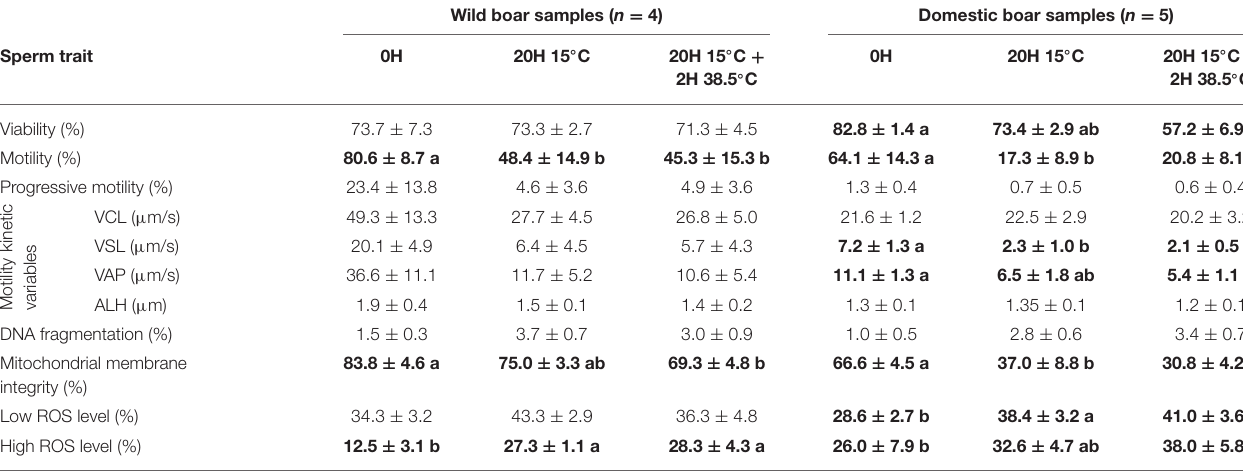
TABLE 1 | Wild ( Sus scrofa ) and domestic ( Sus scrofa domestica ) boar sperm quality variables (mean ± SE). Wild boar samples ( n = 4) Domestic boar samples ( n = 5)